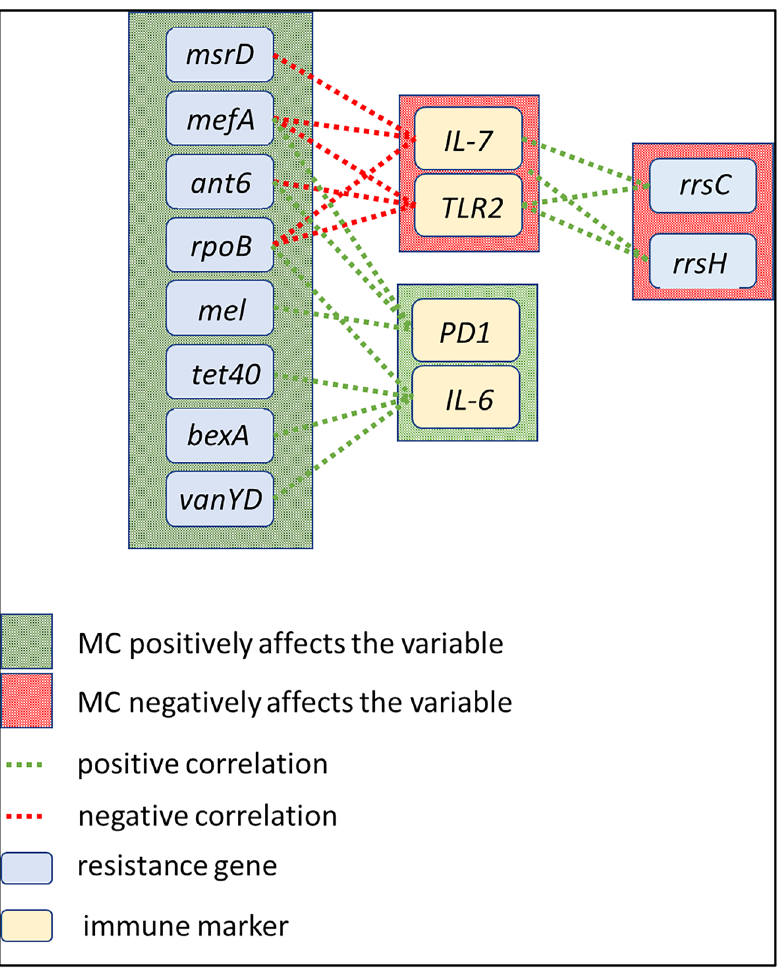
Figure 6. Correlated resistance genes and immune markers. MC exposure changes the resistance profile of the gut microbiome and impacts the expression of immune markers. The abundance of antibiotic-resistant genes correlated strongly with that of immune markers. In the figure, green edges represent positive correlations and red edges represent negative correlations. However, all the correlation values drop dramatically when conditioned on MC exposure. Conditional independence (CI) tests were performed with bnlearn R package with the Mutual Information